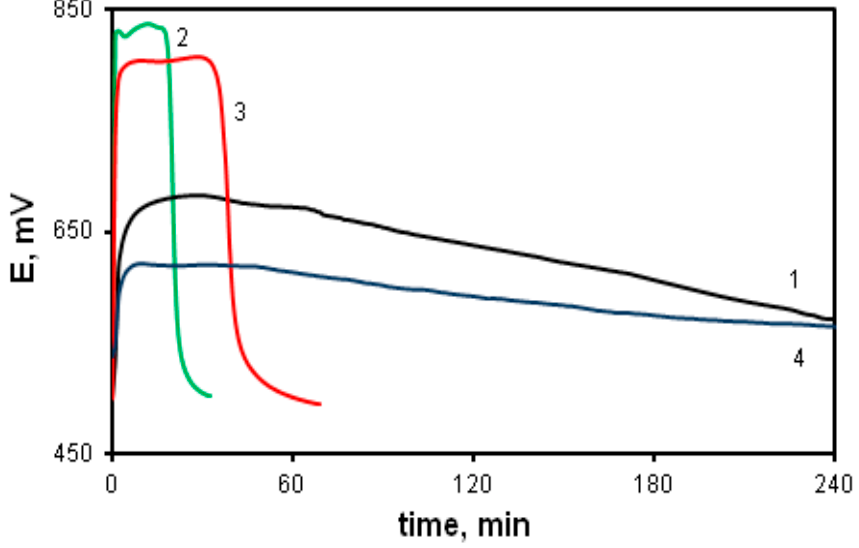
Figure 6. Time dependences of the redox potential during the oxidation reaction of MADCB (1); DADCB (2), and aniline (3) at [HCl] = 0.5 mol/L, as well as MADCB at [HCl] = 1 mol/L (4).